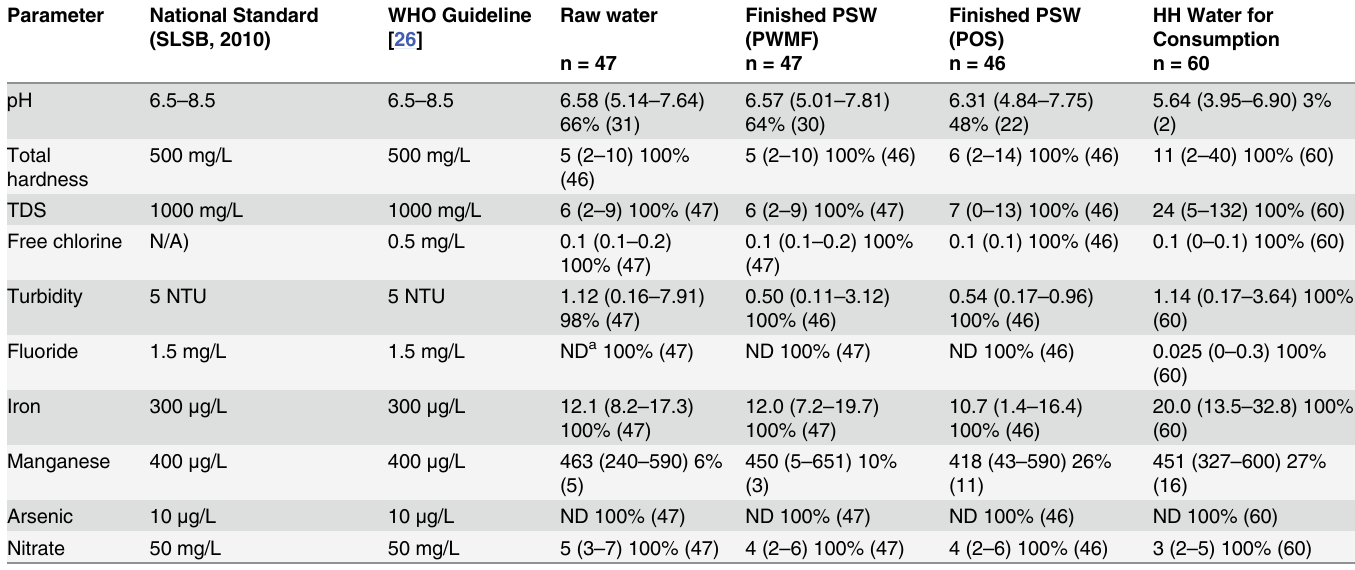
Table 3. Results of chemical analysis for raw water and finished packaged sachet water (PSW) samples. Mean (range), % compliant with WHO guide- lines,